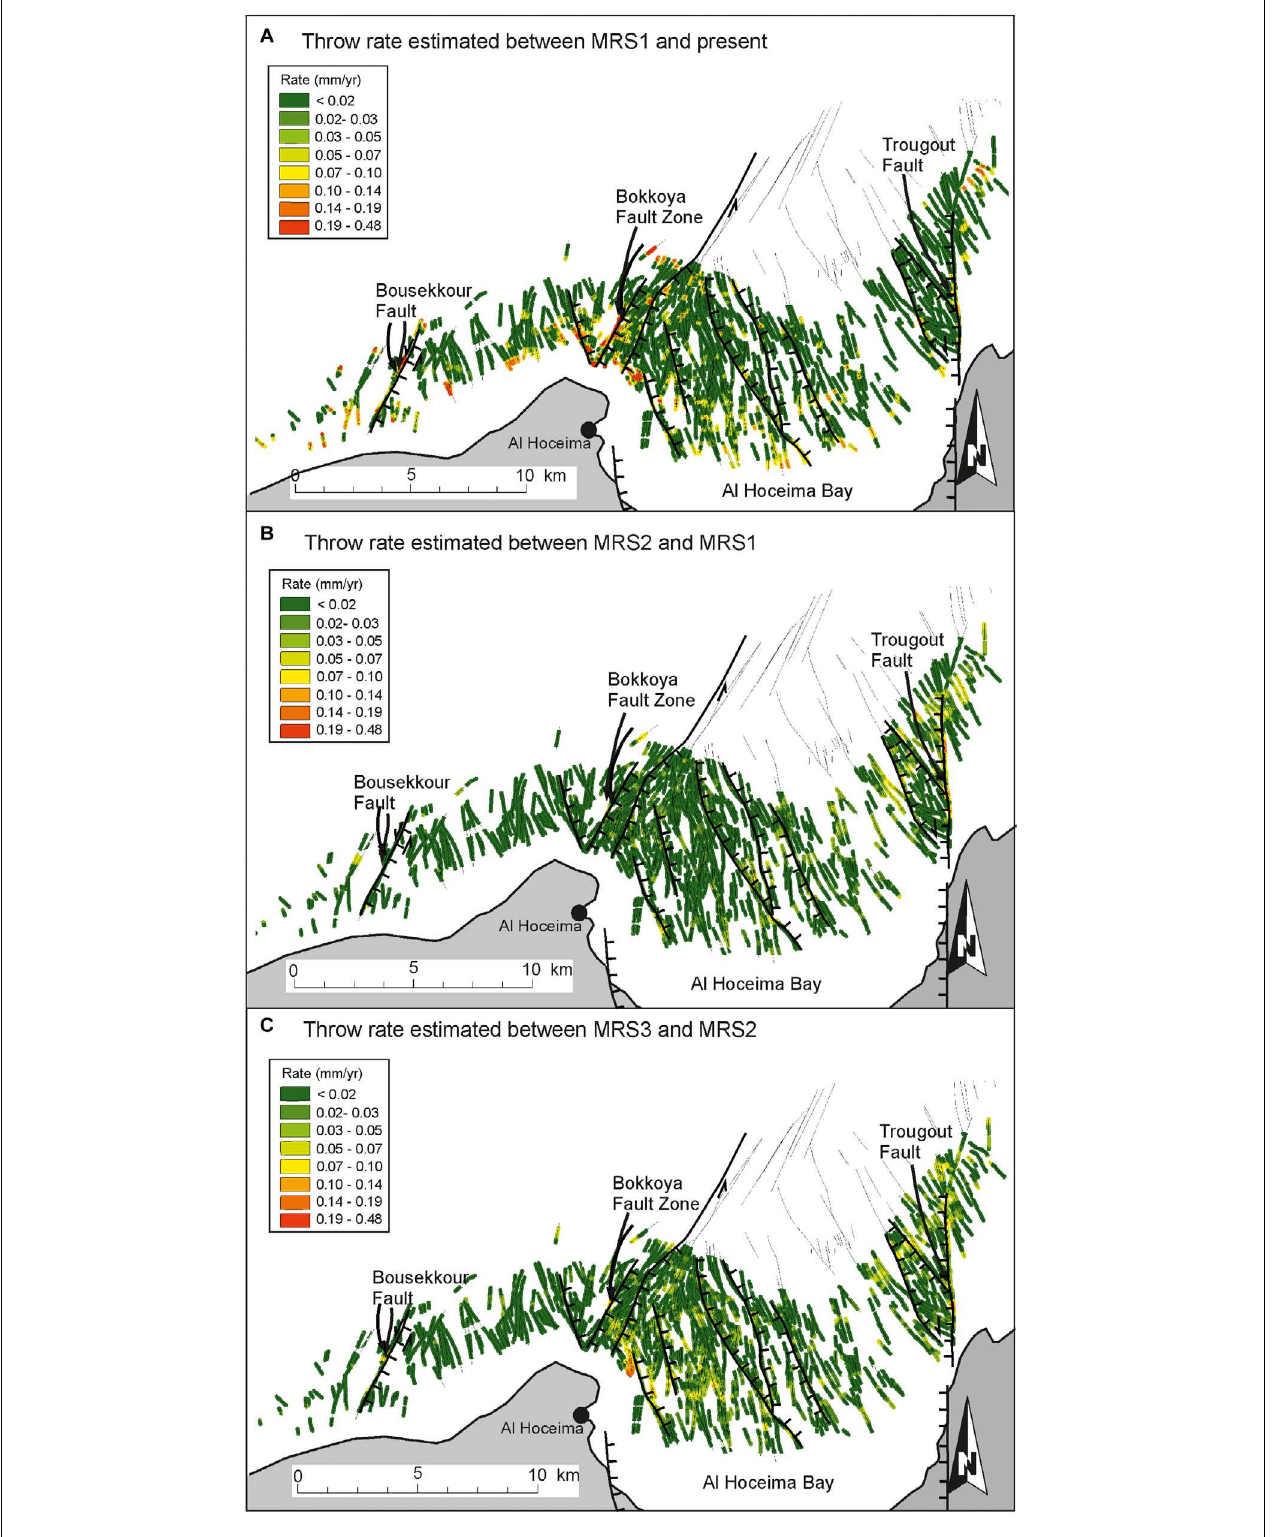
FIGURE 8 | Throw rate maps, including the traces of faults from Lafosse et al. (2016, 2018), with the main faults traces highlighted. (A) Deformation rates between MRS1 and present day. (B) Between MRS2 and MRS1. (C) Between MRS3 and MRS2. Note that the scale of deformation rates between MRS1 and present day is different due to the high values